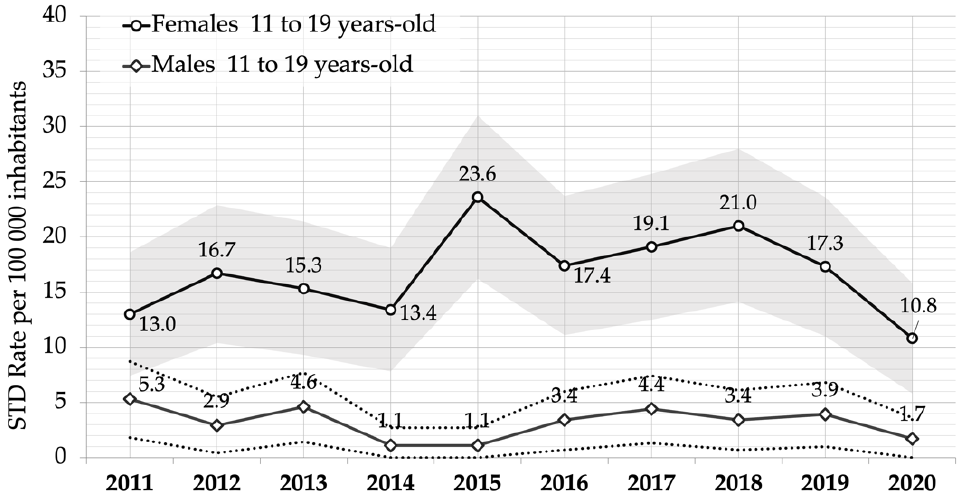
Figure 1. Sexually transmitted infections (STIs) rate per 100,000 inhabitants and 95% confidence intervals (grey and dotted areas), in 11 to 19-year-old adolescents by gender. Year 2011–2020, Piedmont region, Italy.